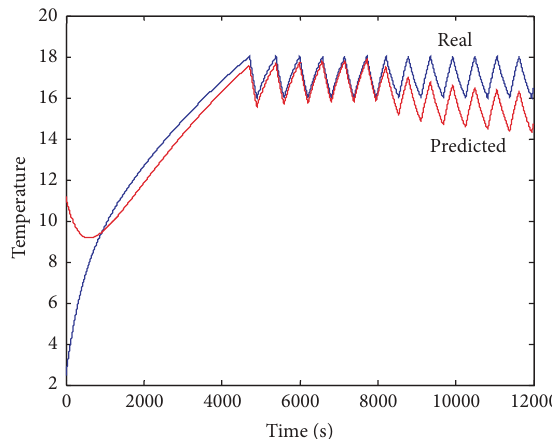
Figure 11: Real and predicted temperature of zone I, with an extra heat source powered on at 𝑛 = 8000 .